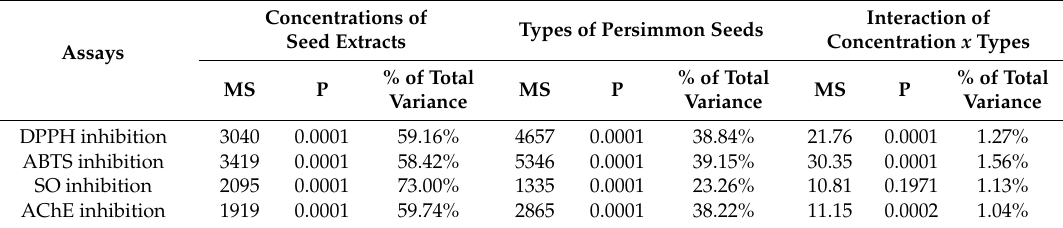
Table 2. Two-way ANOVA of the bioassays performed for different cultivars of persimmon seeds and their concentrations. Concentrations of Interaction of Types of Persimmon Seeds Seed Extracts Concentration x Types Assays % of Total % of Total % of Total MS P Variance Variance